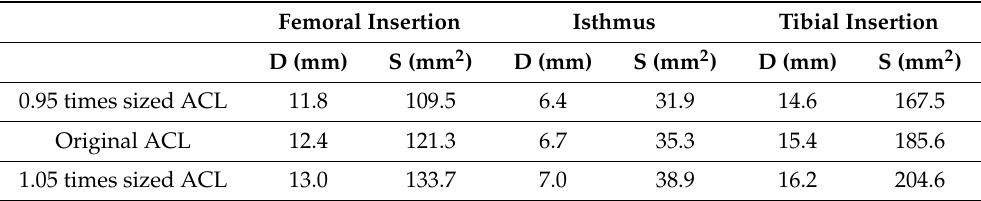
Table 1. Effective diameter (D) and cross-sectional area (S) of the bone insertion sites and the isthmus of the ACL models.